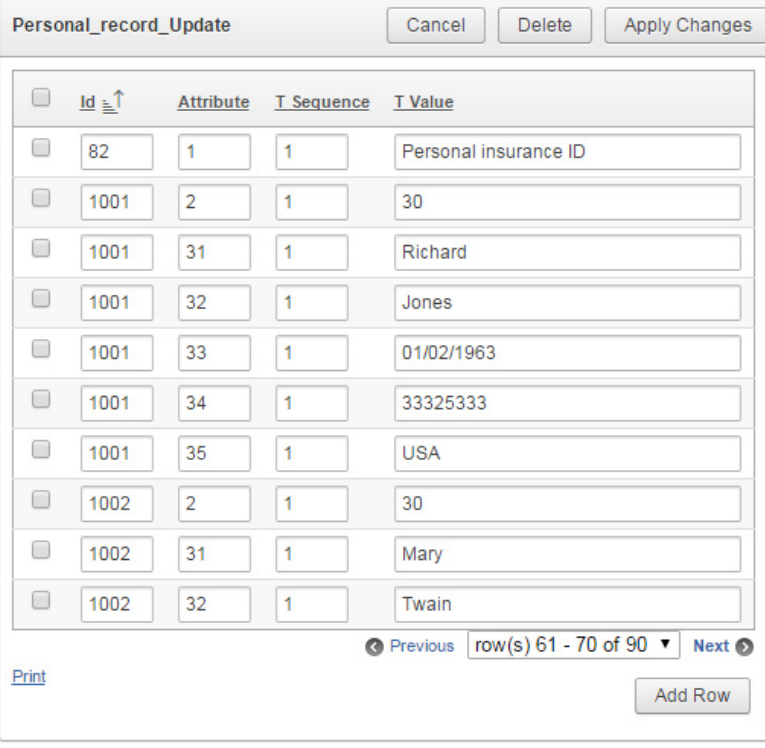
Figure 4. Attribute